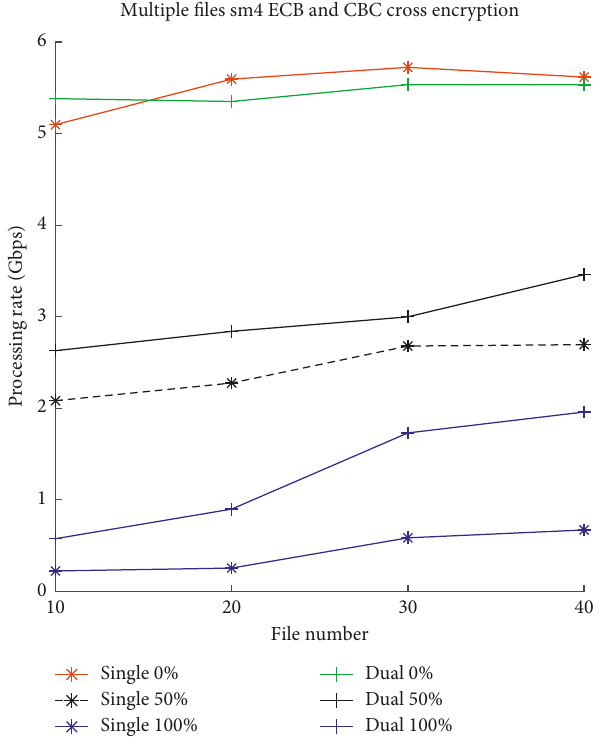
Figure 12: Processing rate comparison of dual channel and single